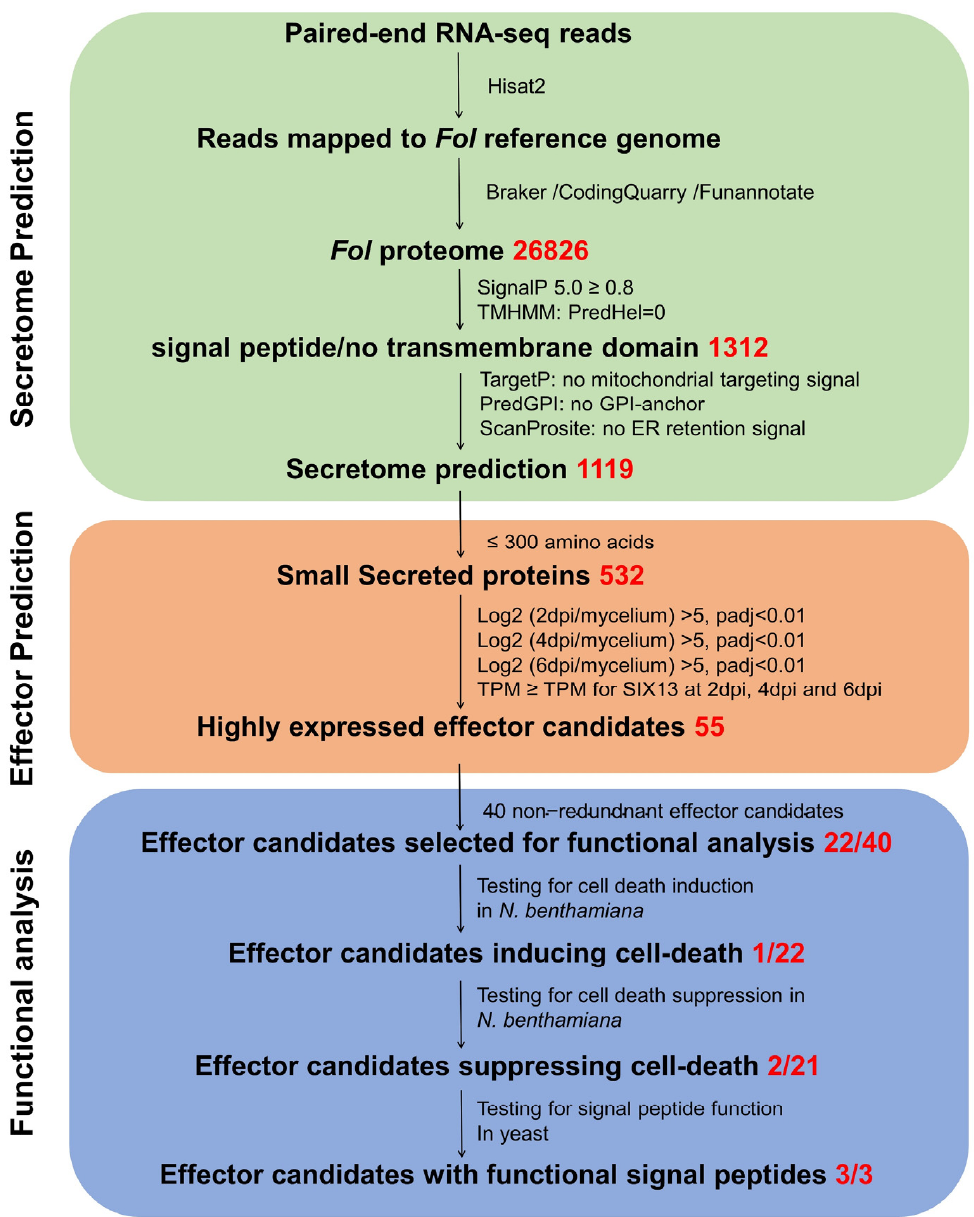
Figure 1. Pipeline for the bioinformatic prediction and functional analysis of Fol effector candi- dates. Three main steps are included in this pipeline: Prediction of the Fol secretome based on transcripts aligned to the PacBio-sequenced Fol4287 reference genome, identification of Fol genes en- coding small, secreted proteins that were differentially expressed during Fol infection and functional analysis of novel effector candidates. Based on the expression profile of the SIX13 gene, which had the lowest transcript per million (TPM) value among the 13 SIX genes present in Fol race 2, 55 genes were selected as effector candidates. Functional analysis was carried out on 22 of the 40 non-redundant effector candidates, excluding the 13 SIX genes present in Fol race 2.